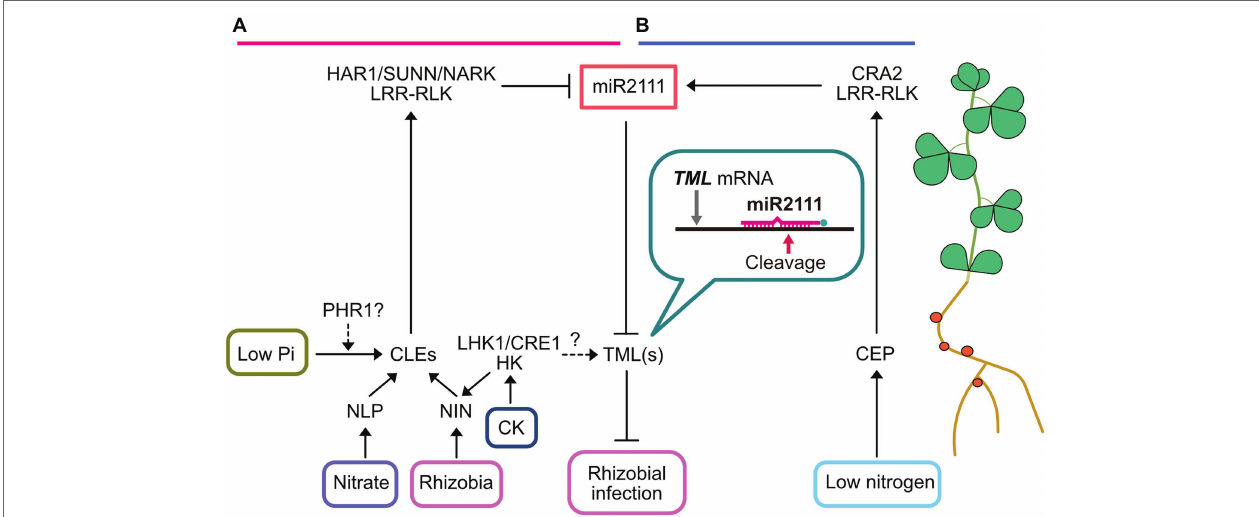
FIGURE 1 | Current model of miR2111-mediated control of rhizobial infection. (A) Rhizobial infection and nitrate treatments induce CLAVATA3/EMBRYO- SURROUNDING REGION (CLE) small peptide production in roots. The expression of rhizobia- and nitrate-responsive specific CLE peptides is activated by transcription factors NODULE INCEPTION (NIN) and NIN-LIKE PROTEIN (NLP), respectively. Cytokinin (CK) application induces CLE expression depending on NIN through cytokinin receptor histidine kinases (HKs), such as LOTUS HISTIDINE KINASE1 (LHK1) and CYTOKININ RESPONSE1 (CRE1). Grafting experiments using lhk1 -mutants demonstrated that the induction of these CLEs might partially depend on HK in the roots. It is also possible that LHK1 locally influences TOO MUCH LOVE ( TML ) expression in roots, which is independent of CLEs (dashed line with question mark). Moreover, PHOSPHATE STARVATION RESPONSE 1 (PHR1) likely contributes CLE expression in response to low-phosphate conditions. Arabinosylated derivatives of these CLE peptides are transported through xylem and directly recognized by leucine-rich repeat receptor-like kinases (LRR-RLKs), such as HYPERNODULATION ABERRANT ROOT1 (HAR1), SUPER NUMERIC NODULES (SUNN), and NODULE AUTOREGULATION RECEPTOR KINASE (NARK). These LRR-RLKs inhibit miR2111 accumulation in the shoot and systemically increase TML mRNA levels in the roots to inhibit rhizobial infection. (B) In contrast to autoregulation of nodulation (AON), CEP peptide is produced in the roots to systemically enhance rhizobial infection in response to low nitrogen availability. Root-derived CEP peptides are perceived by shoot-acting compact root architecture 2 (CRA2) LRR-RLK. CRA2 increases miR2111 levels and consequently enhances rhizobial infection in the roots. Hence, these two antagonistic regulatory events might maintain ideal nodule numbers to adapt to fluctuating nitrogen